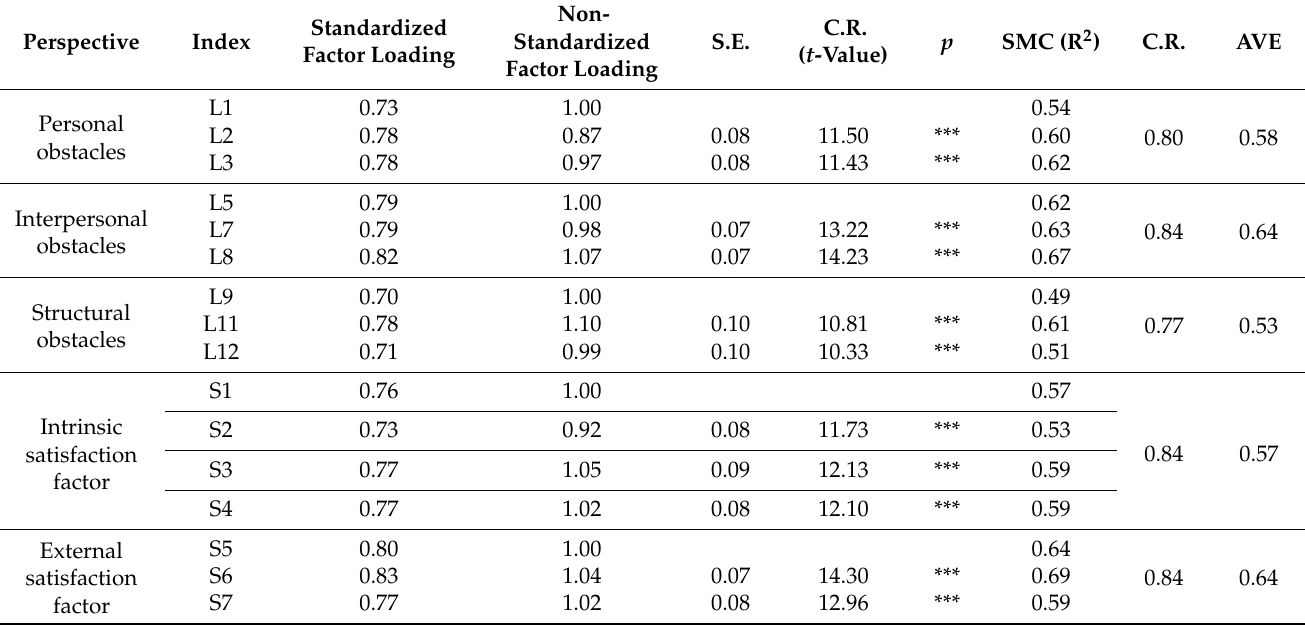
Table 4. Leisure obstacles and job satisfaction model—confirmatory